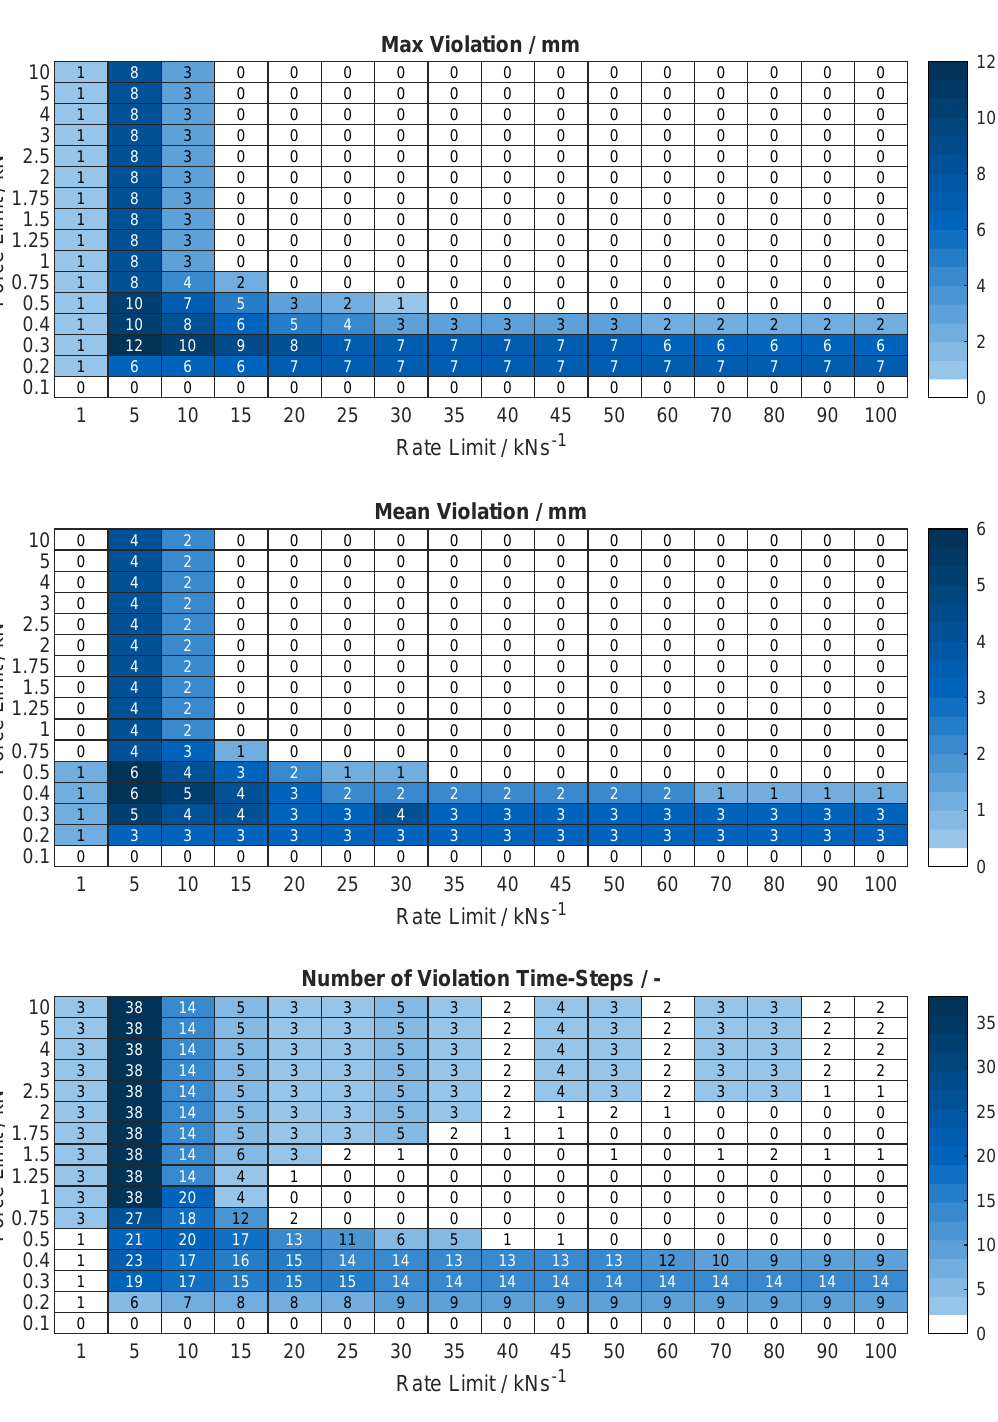
Figure A18. Suspension-deflection constraint violations in the 90kmh − 1 BC profile